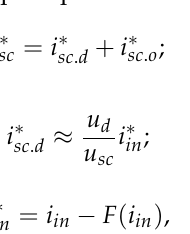
Figure 19. Generalised single-circuit ACS of a supercapacitor energy